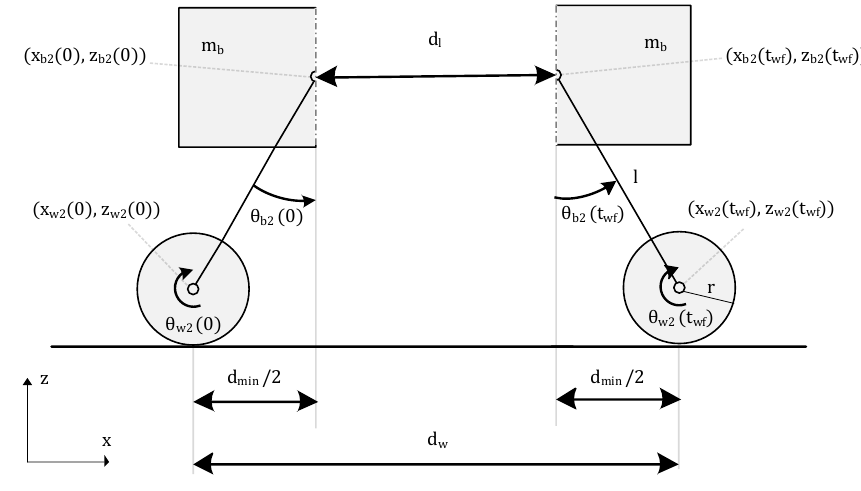
Figure 3. Distance covered by the wheels during the acceleration step. It is used to estimate the slip